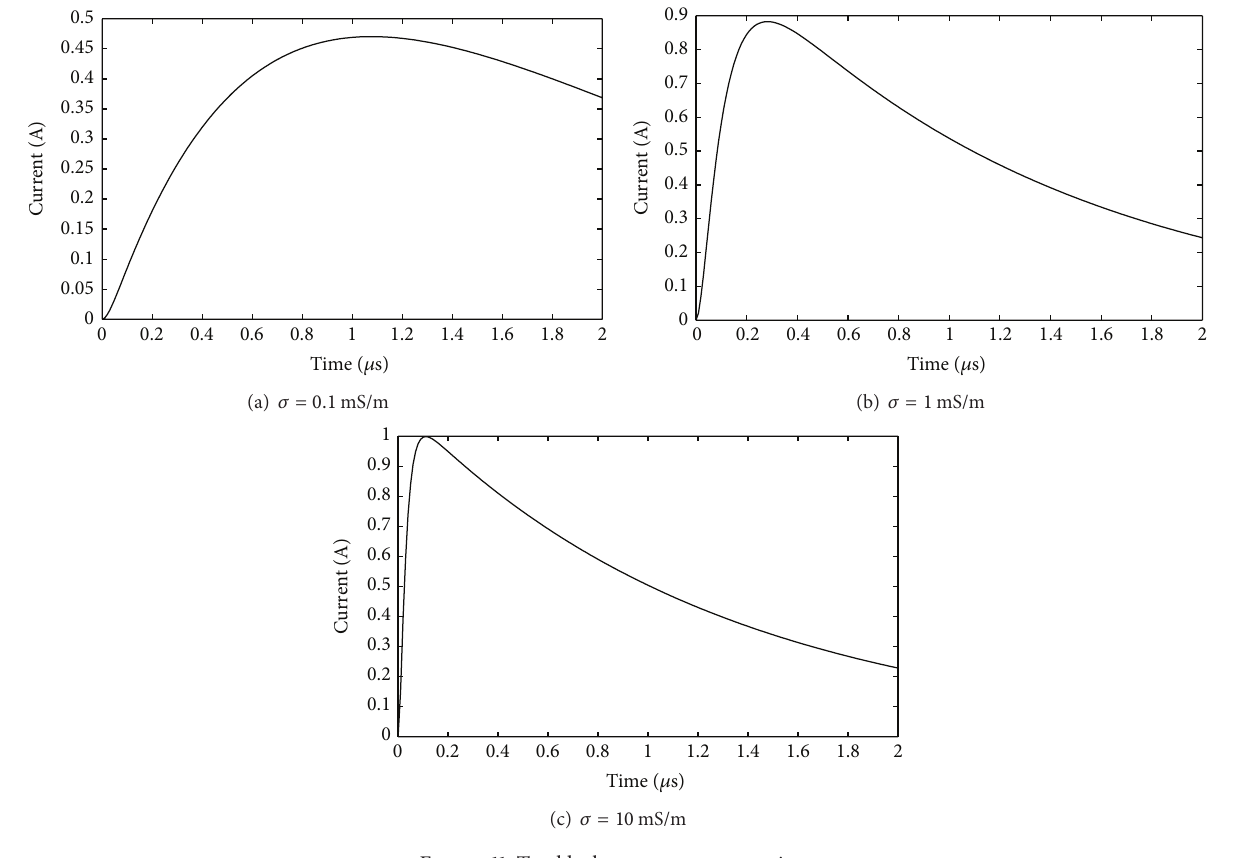
Figure 11: Total leakage current versus